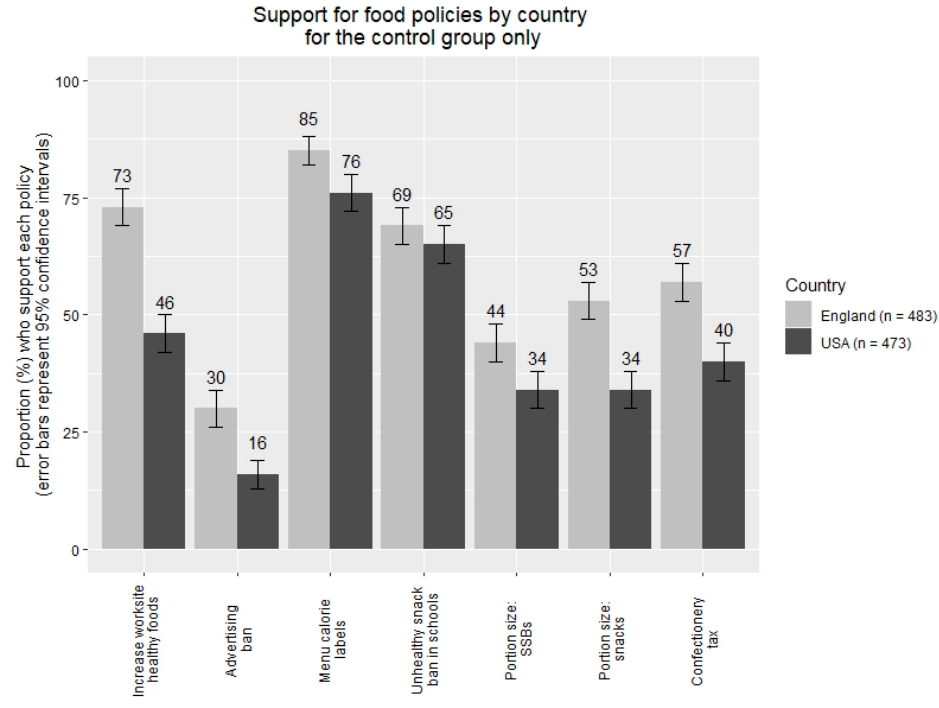
Figure 1. Study 2: Support for obesity policies by country.